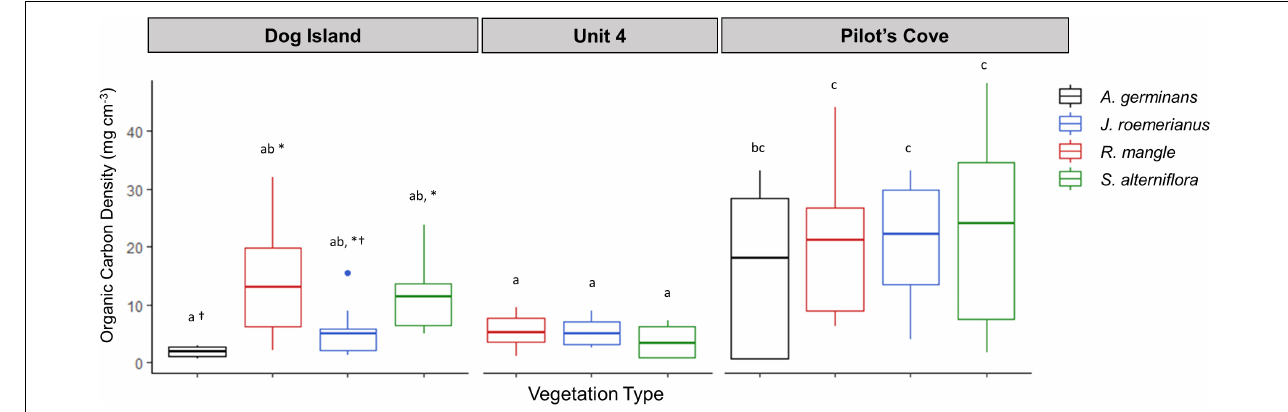
FIGURE 2 | Boxplots of soil organic carbon density beneath each vegetation type as indicated by color, at each site. Horizontal lines in boxplots indicate mean. Lower and upper hinges indicate the first and third quartiles and upper and lower whiskers denote values within 1.5 the interquartile range. Lowercase letters indicate significant differences across sites, while asterisks and crosses indicate statistical differences within